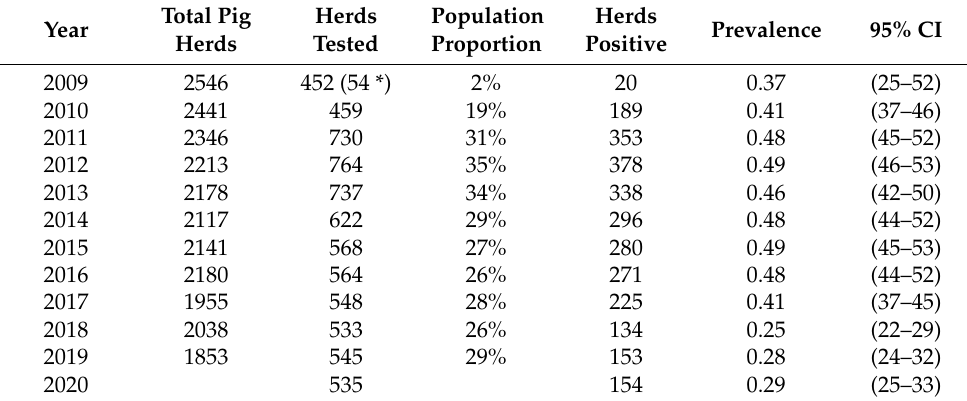
Table 1. Active serosurveillance gave yearly prevalence estimates of influenza A(HIN1)pdm09 infection in pig herds. Testing every year from 2009 to 2020 involved 500–700 randomly selected pig herds, a coverage of between one-quarter to one-third of total pig herds in